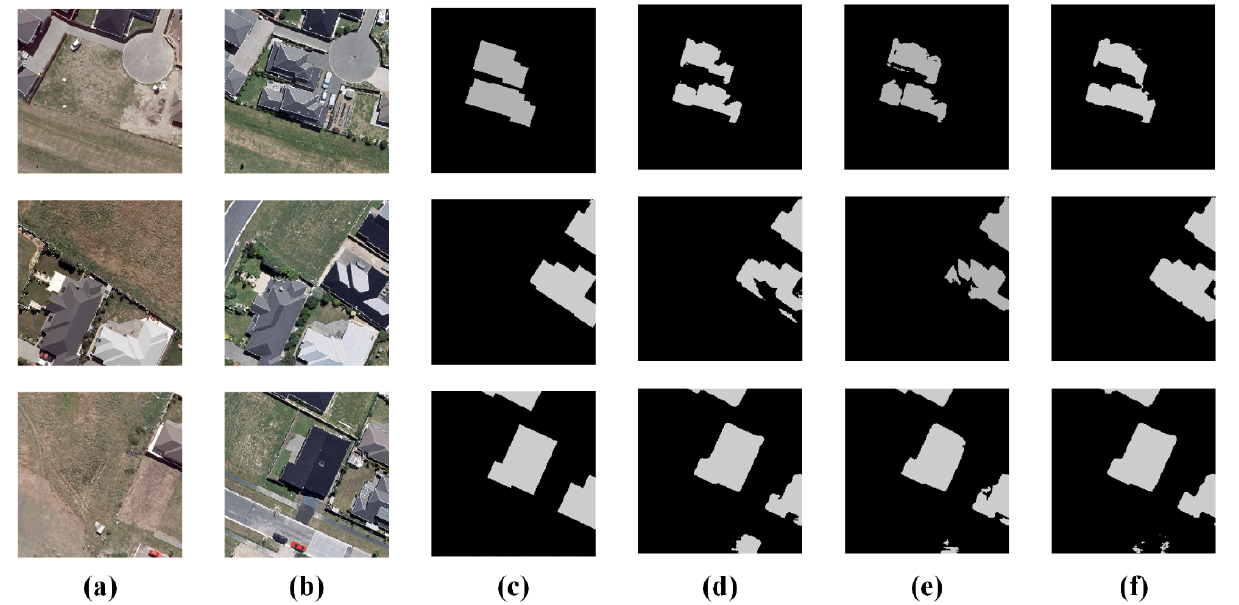
Figure 6. ( a ) Before image; ( b ) After image; ( c ) Label; ( d ) EF-Dens ; ( e ) MDNET; ( f ) Ours.